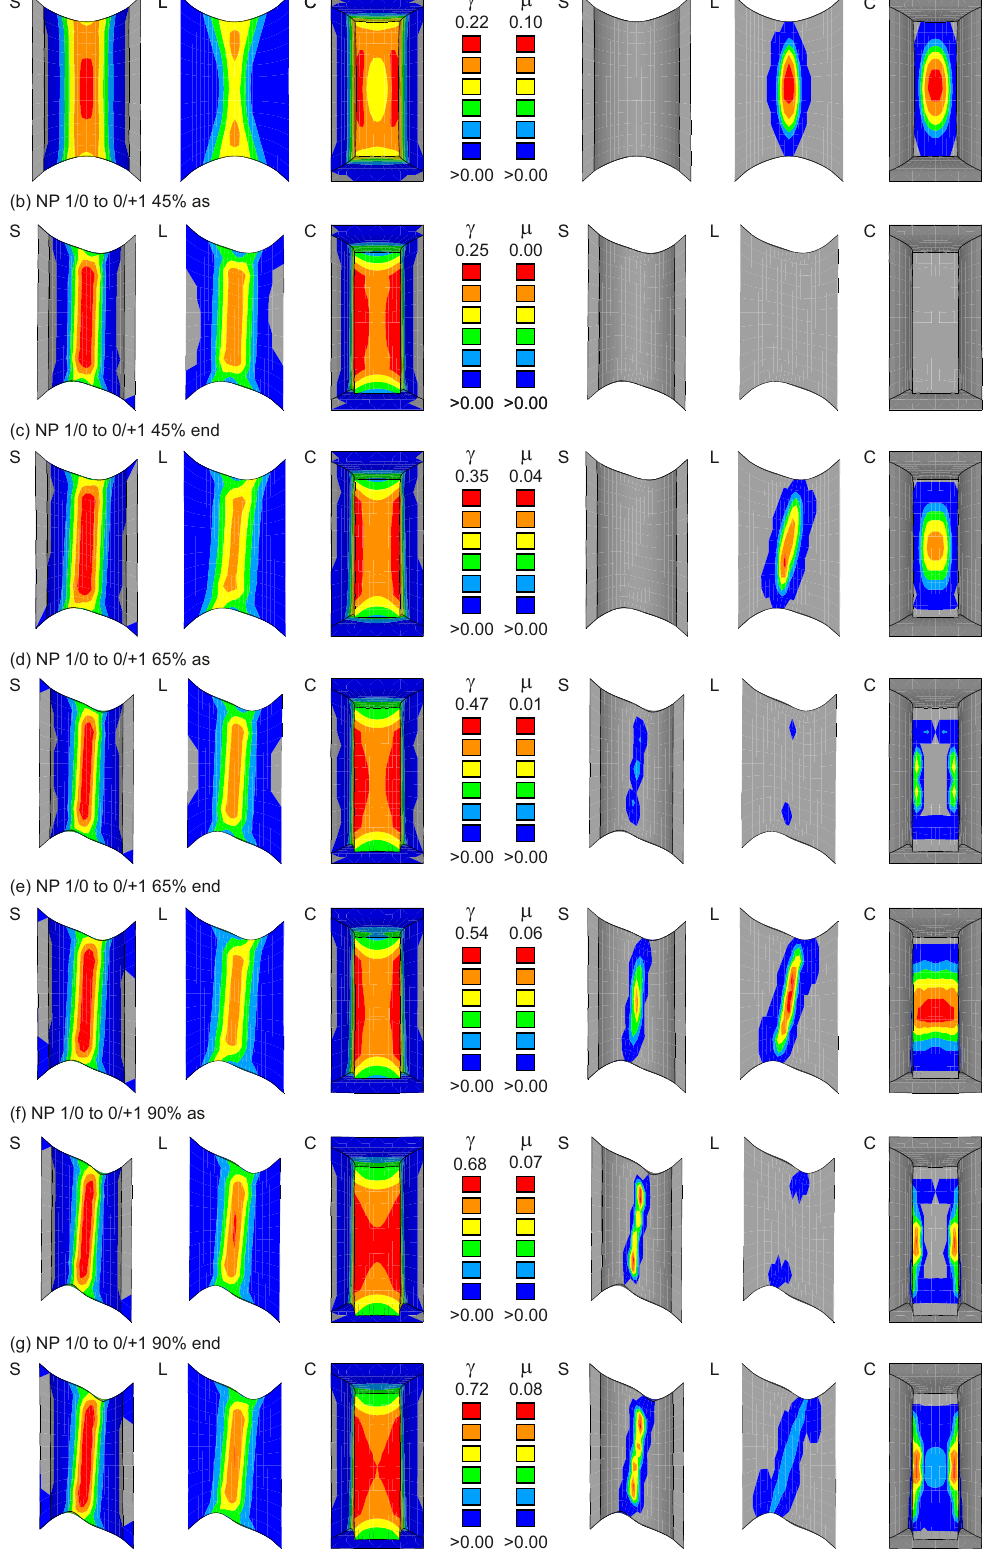
Figure 13. Equivalent plastic strain γ and equivalent damage strain µ : S—surface, L—longitudinal section, C—cross